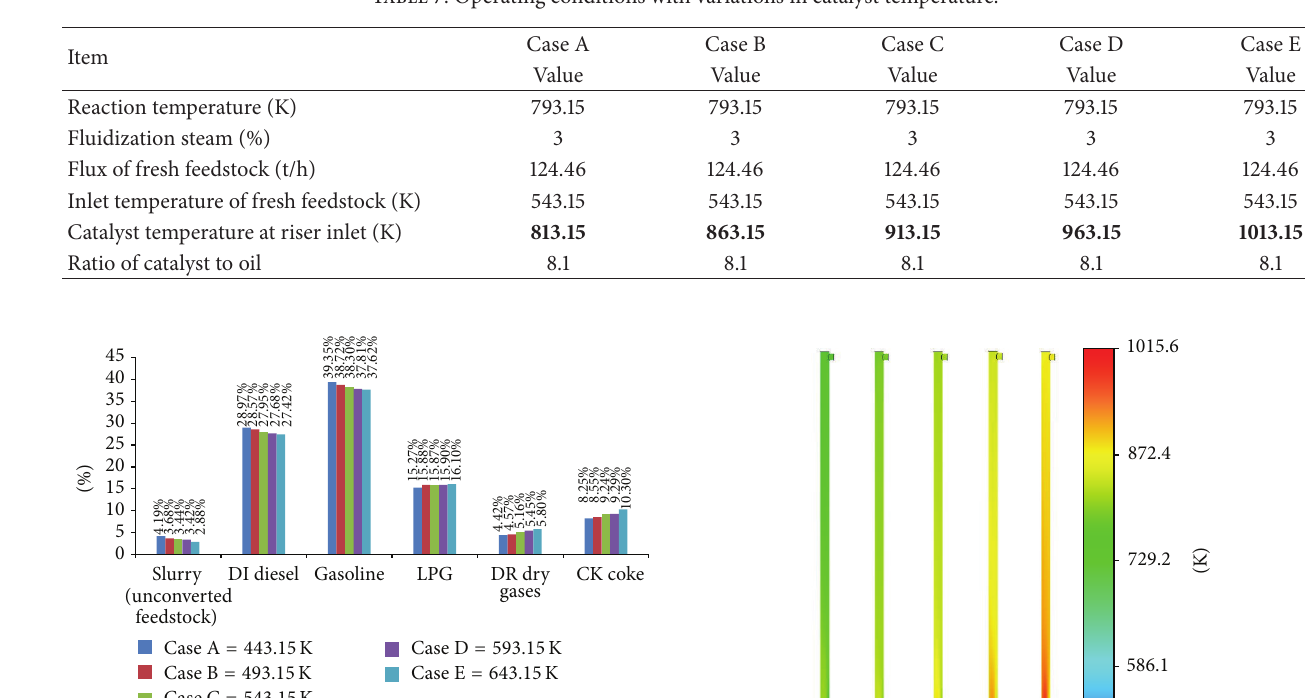
Table 7: Operating conditions with variations in catalyst temperature.